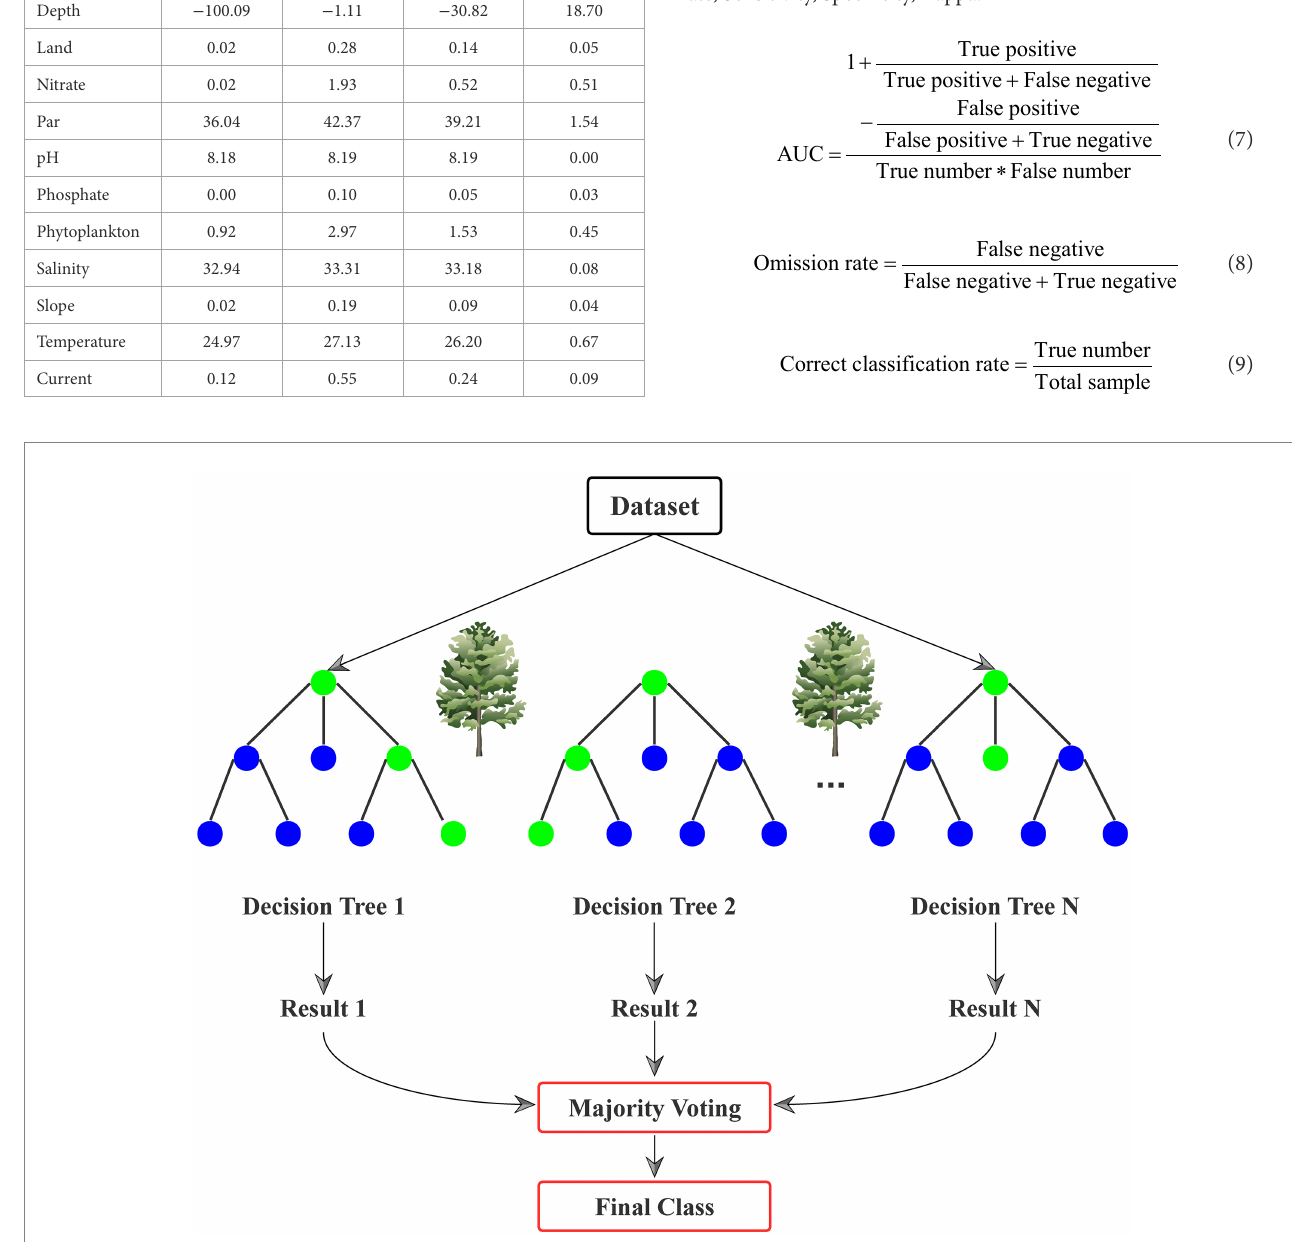
FIGURE 2 Random forest model